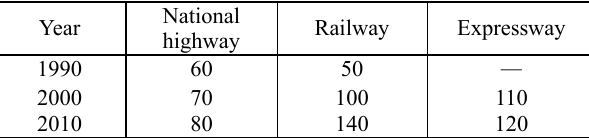
Table 5. Average velocity of road network in the YRD (km/h) — means there was no expressway in China before